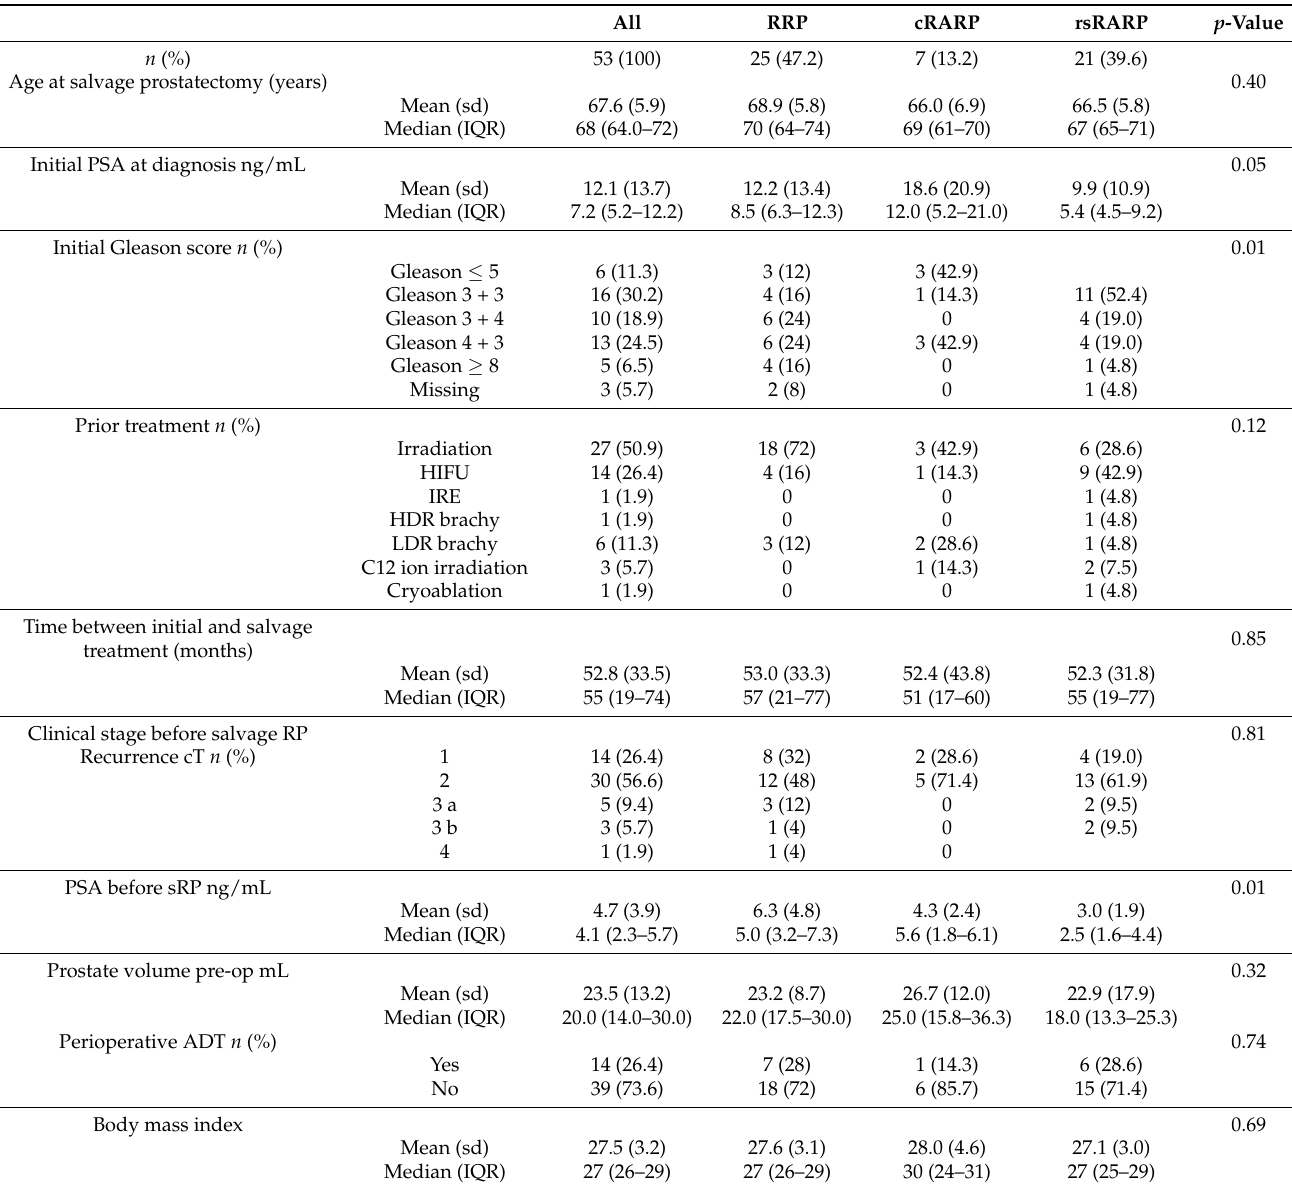
Table 1. Patient